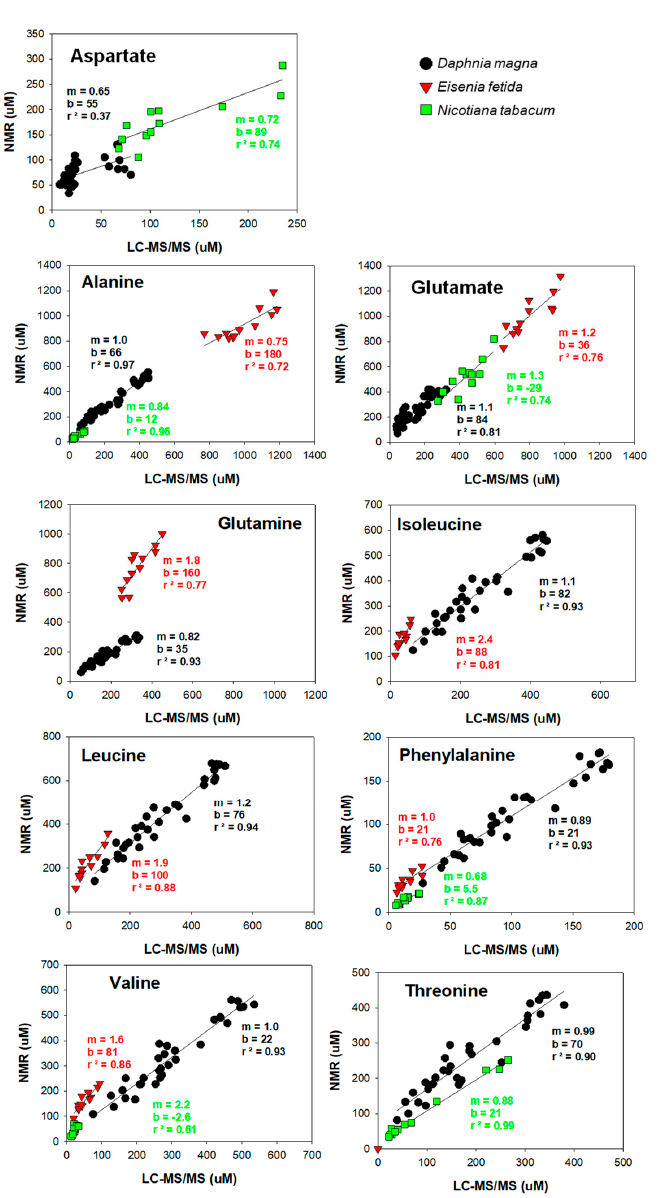
Figure 5. Comparison of amino acid quantification by 1 H NMR and LC ‐ MS/MS in polar extracts from three different environmentally relevant model organisms.